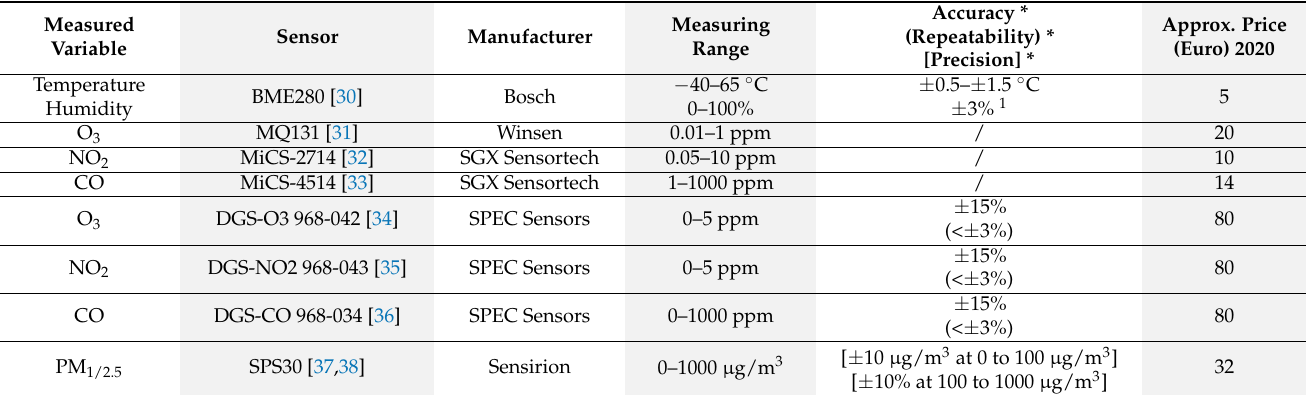
MQ131 [31] Winsen 0.01–1